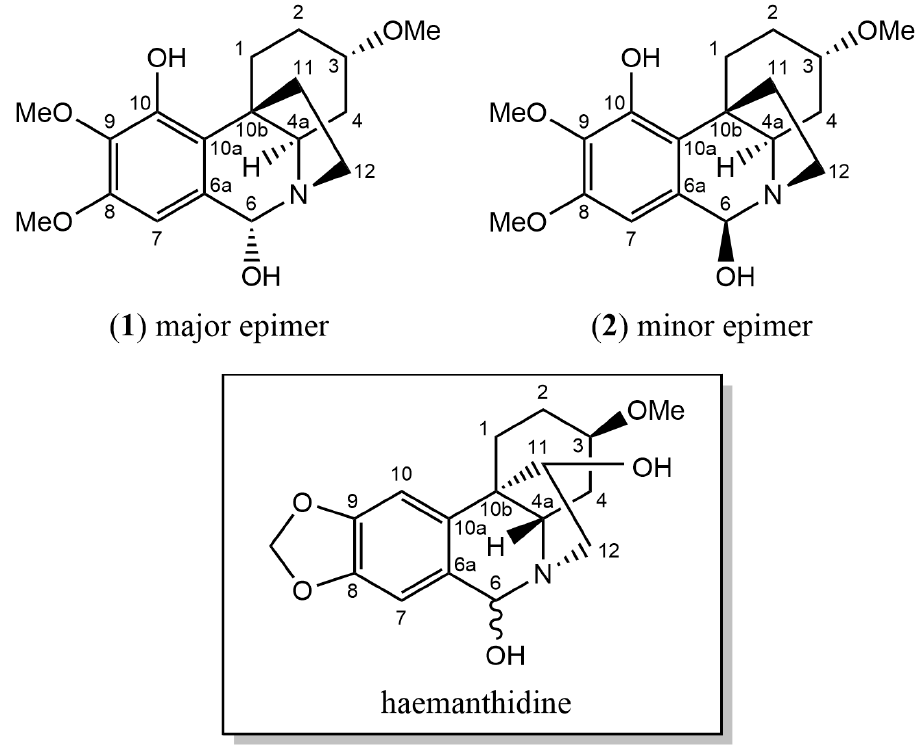
Figure 2. Structures of 6 α -hippeastidine (compound 1 ), 6 β -hippeastidine (compound 2 ) and haemanthidine.